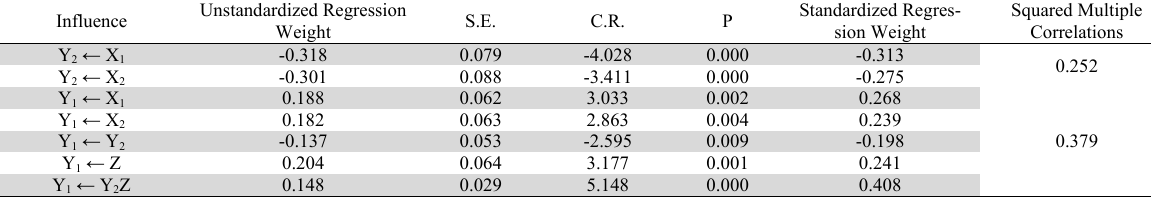
Analysis Results of Structural Model with Moderation Unstandardized Regression Influence Weight